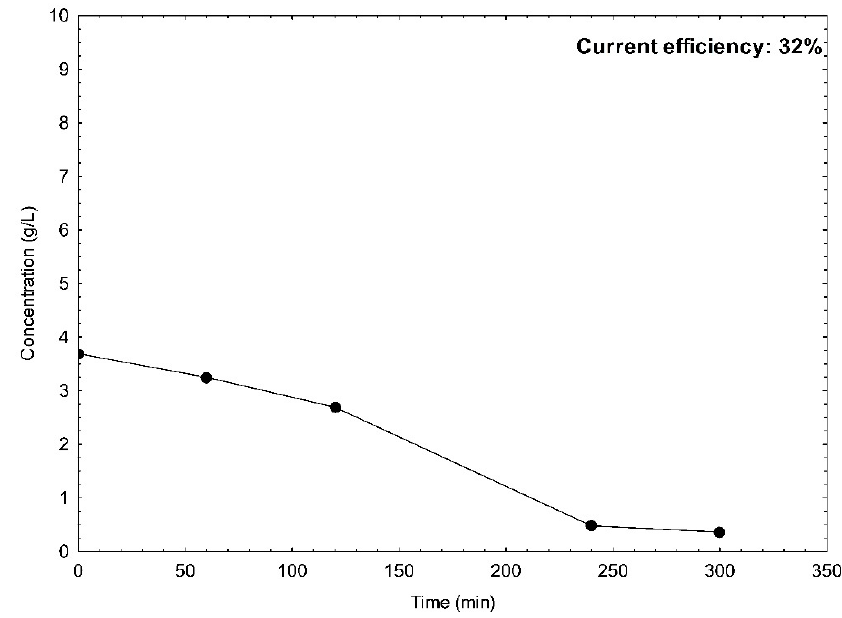
Figure 6. Variation of copper concentration as a function of electrowinning time in the sequential test, presented in Figure 4, at 250 A/m 2 , pH = 4 and room temperature for the CuSO 4 synthetic solu- tion.